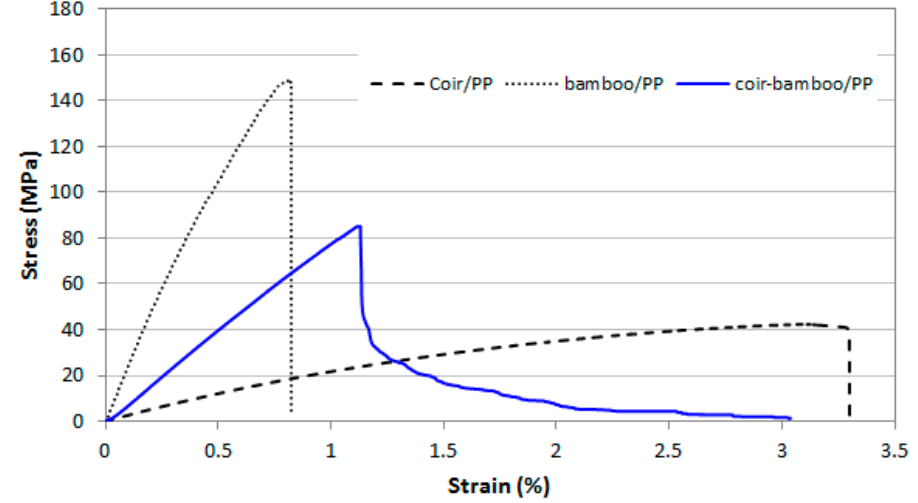
Figure 4. Typical tensile stress-strain curves of UD coir-bamboo / PP hybrid composites displayed together with stress-strain curves of UD mono coir / PP and UD mono bamboo / PP composites.